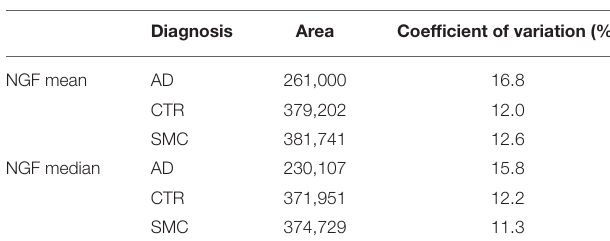
TABLE 3 | Mean and median of the NGF peaks area for the three diagnostic